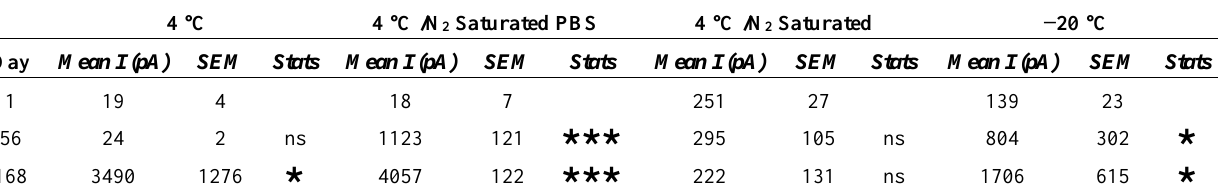
Table 2. Shelf-life data for Pt-PPD electrodes exposed to various storage